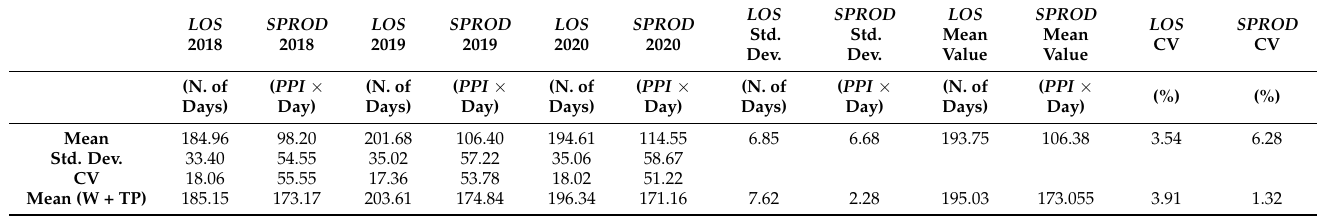
Table 5. Yearly mean values of LOS and SPROD at tree level (from T layer). Mean and stan- dard deviation values are computed along time. CV is the correspondent coefficient of variation (std. dev./mean ×